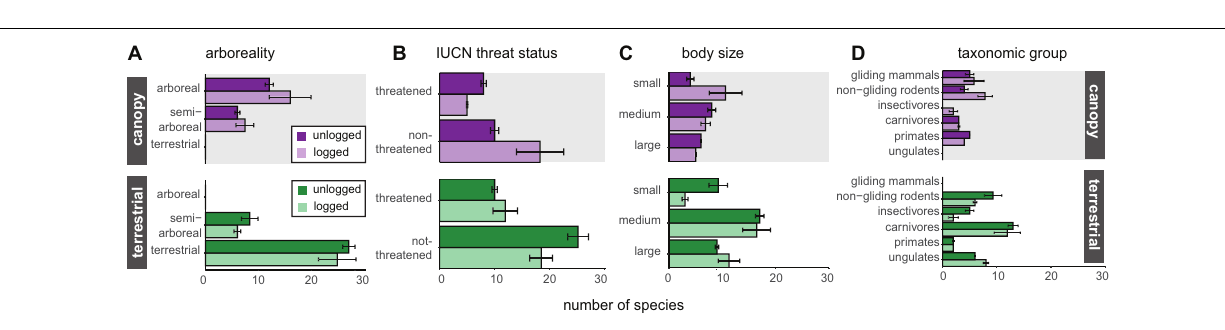
FIGURE 2 | Rarefied species accumulation curves for arboreal and terrestrial mammal communities in panel (A) both forest types combined, (B) unlogged forest only, and (C) logged forest only. Curves were extrapolated (dashed line) to approximately double the minimum observed sample size in each comparison. Confidence intervals (CIs) were set at 84%, which has been demonstrated equivalent to a p value of 0.05 significant differences (MacGregor-Fors and Payton, 2013). CIs are represented by shaded areas around the curves. Additional analyses with CIs at 95% are presented in Supplementary Figure 1 for comparison.